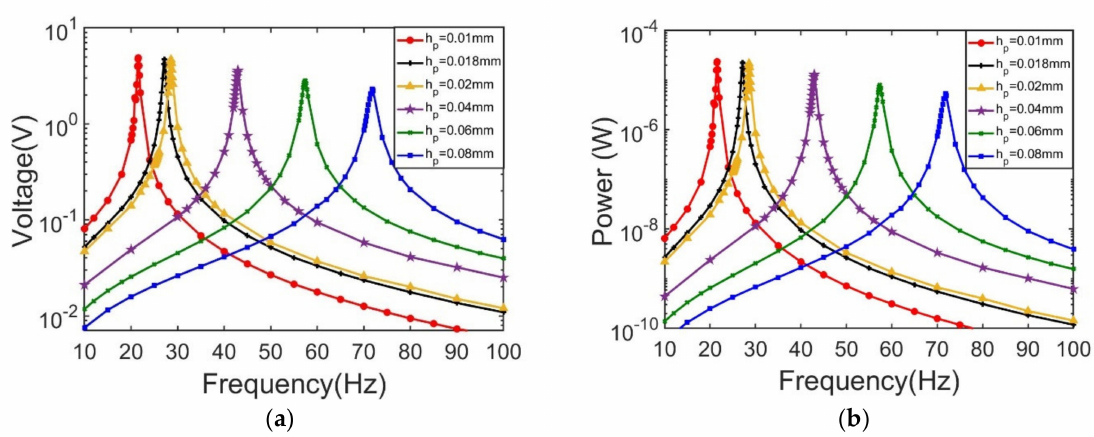
Figure 12. Frequency responses of output voltage and output power at first vibration mode. ( a ) output voltage responses with different piezoelectric layer thicknesses; ( b ) output power responses with different piezoelectric layer